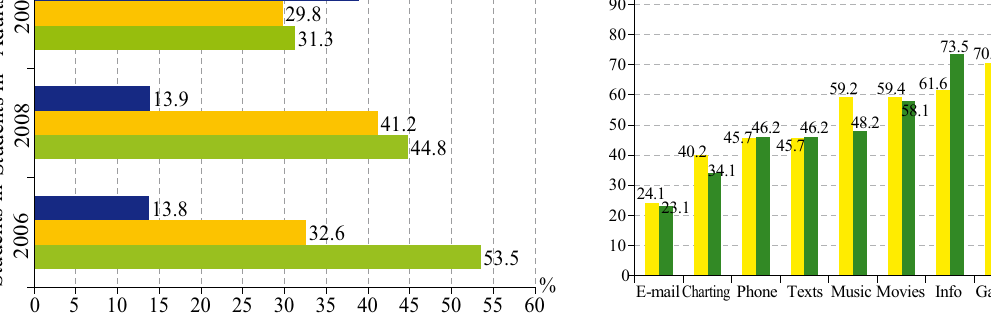
Fig. 7. Comparison of students and adults trips by mode: Table 2. Physical trips replaced by virtual ones Activity – ordering and(or) buying manufactured goods (147 reported positively)